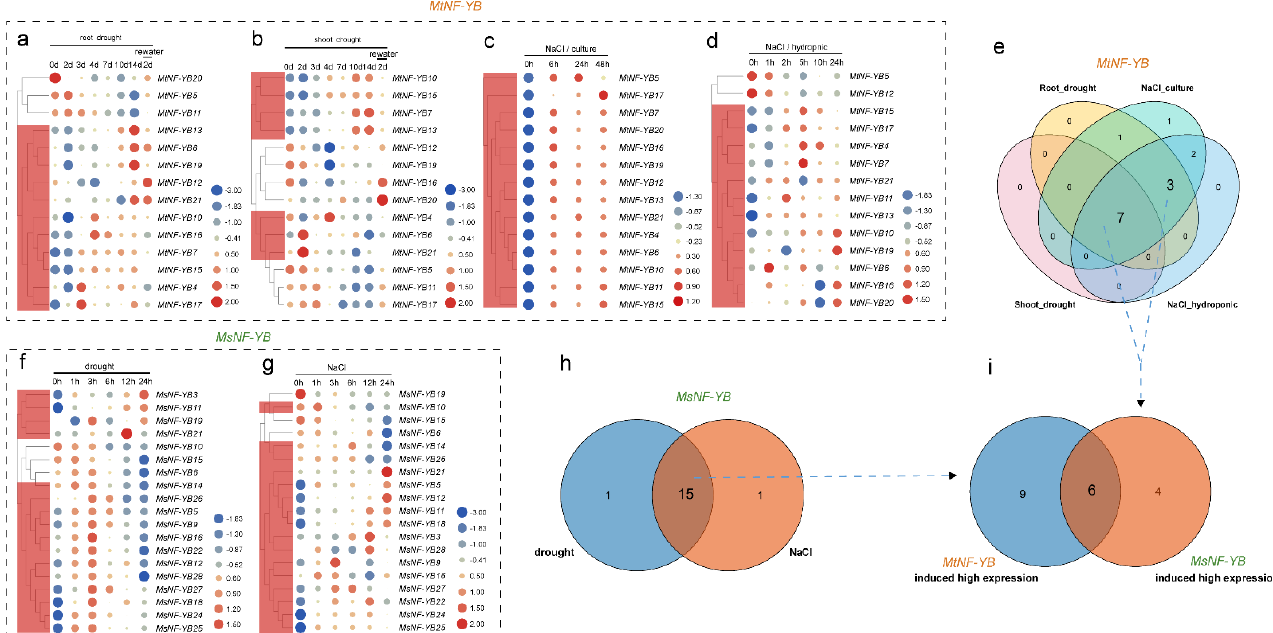
Figure 7. Genechip data of MtNF-YB, transcriptome data of MsNF-YB, and gene expression profiles of different treatments and different times. Each column represents a treatment, each row represents a gene, and each member is normalized in the same column. The relative expression levels are log2-transformed and visualized for heatmap. The color of the circles from blue to red shows the expression level from negative to positive values after normalization. The size of the circles represents the amount of gene expression. The red box indicates genes with increased expression. ( a , b ) Expression level of MtNF-YB genes in roots ( a ) or shoots ( b ) under different drought treatment times. ( c , d ) Expression levels of MtNF-YB genes in roots under different treatment times for NaCl-culture ( c ) or NaCl-hydroponic time ( d ). ( e ) Venn diagram of gene expression levels of MtNF-YB genes after four different treatments. ( f ) Expression levels of MsNF-YB genes under different drought treatment time. ( g ) Expression levels of MsNF-YB genes under NaCl treatment at different time points. ( h ) Venn diagram of expression levels of MsNF-YB genes after two different treatments. ( i ) Venn diagram of genes whose expression levels were increased by stress treatment; these genes were selected based on the homolog listed in Table 1.